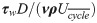
Columns from left to right: Normalized shear stress at the wall, τwD/(νρUcycle¯), normalized relative pressure at the wall, Pw/Pcycle¯, and iso-surface of the relative pressure at threshold levels of ±0.5P/Pcycle¯.